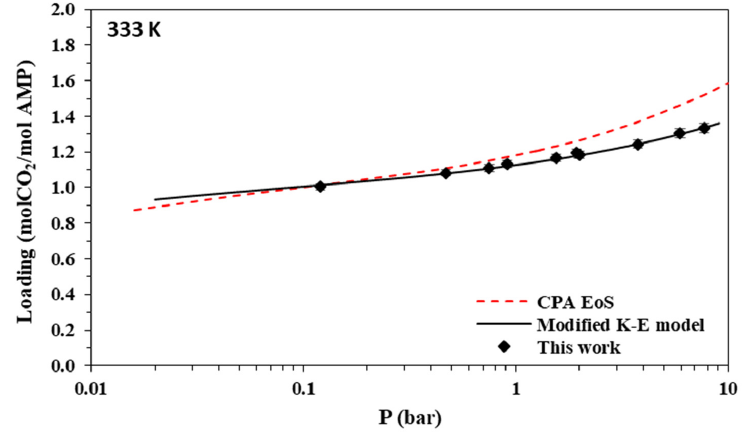
Figure 10. Solubility of CO 2 in aqueous MAPA (30.0% wt.) solutions at 333 K. Experimental data (points, from this work) and correlations (lines) with the CPA equation of state and the modified Kent–Eisenberg model.